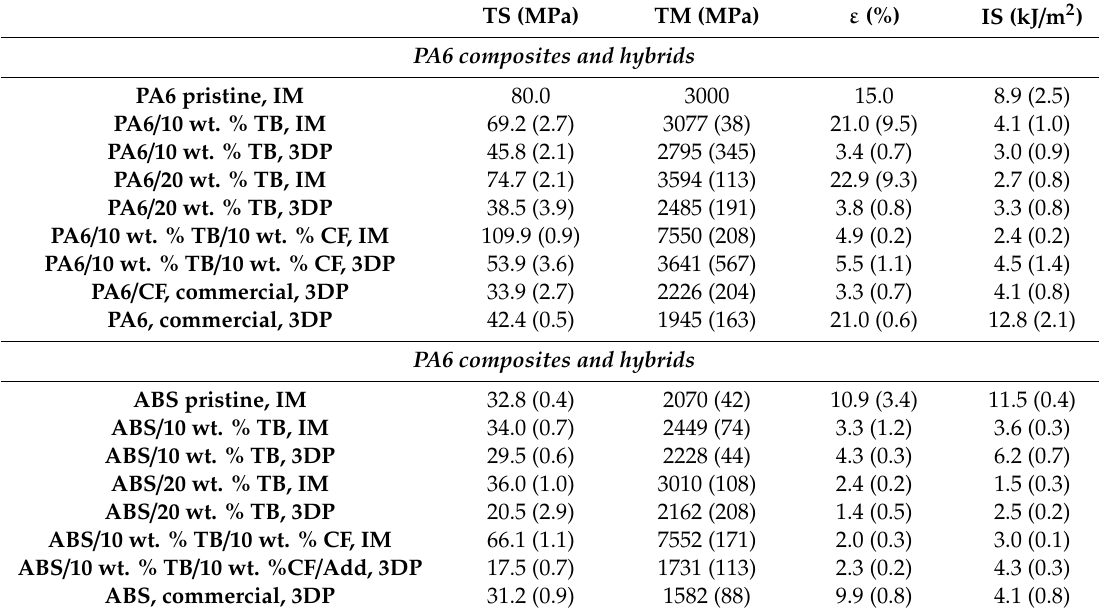
Table 9. Performance (and SD) comparison of injection molded (IM) and 3D printed (3DP)